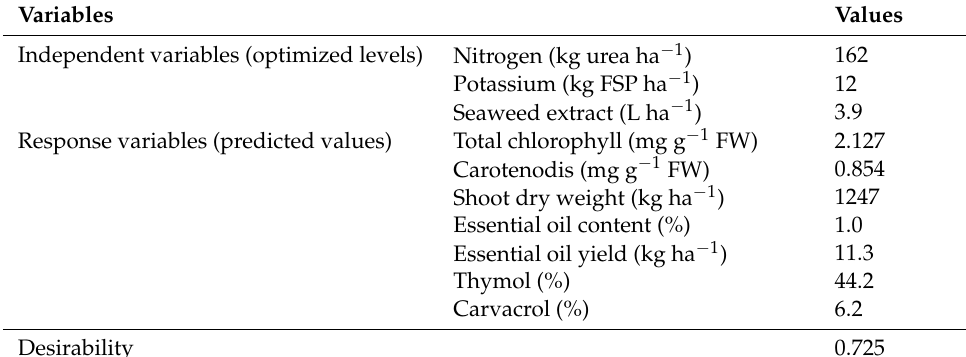
Table 7. The optimized levels of independent variables and the predicted values of thyme responses.